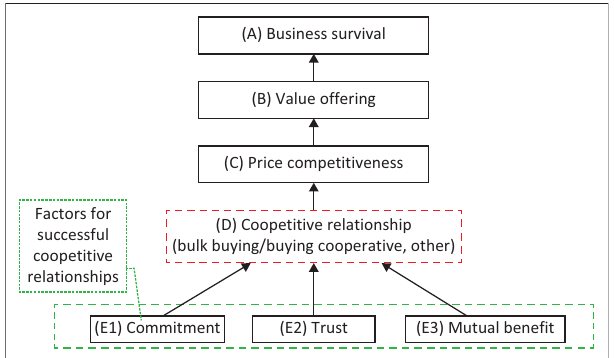
FIG URE 1: The conceptual framework for the